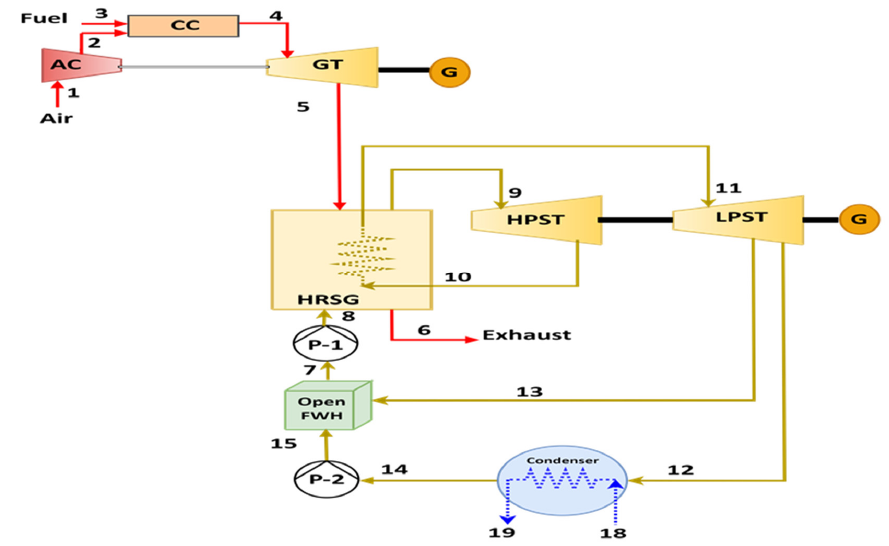
Figure 1. Schematic diagram of the natural gas combined cycle (NGCC).